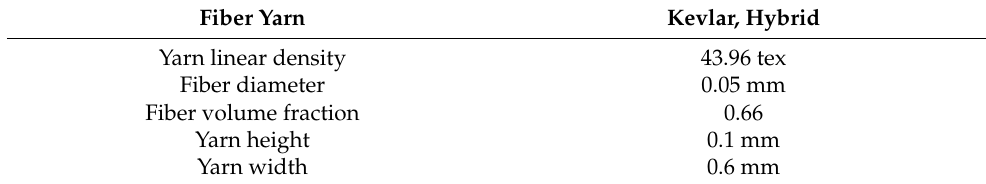
Table 4. Fiber yarn phase properties.